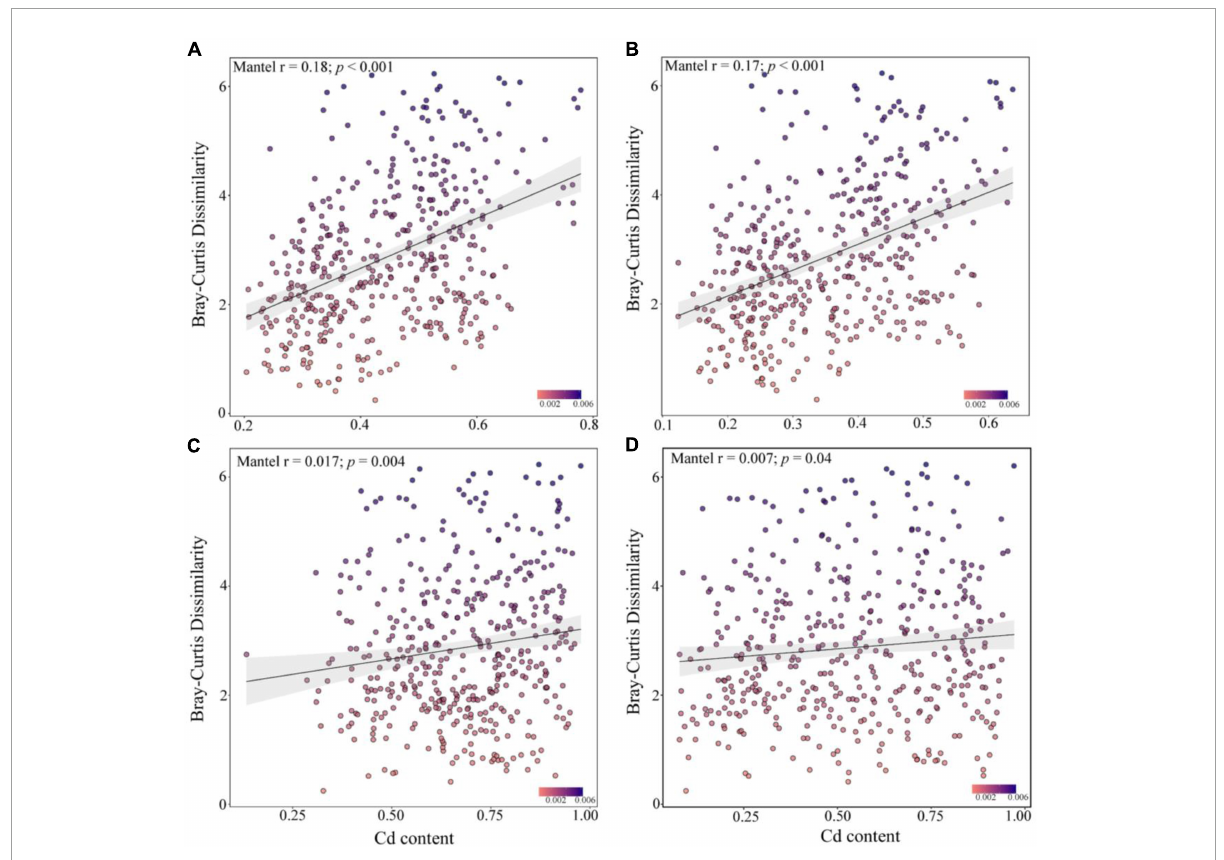
FIGURE5 Mantel correlation between the dissimilarity of abundant bacteria (A) , rare bacteria (B) , abundant fungi (C) , and rare fungi (D) communities and the soil cadmium (Cd)